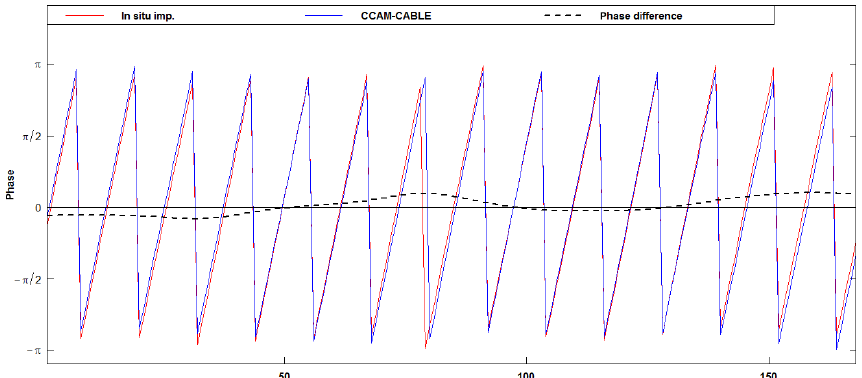
Figure C2. Phase difference between surface soil moisture simulated using CCAM-CABLE, and GLEAM v3a at Skukuza between 2001 and 2014 at period 12 at the